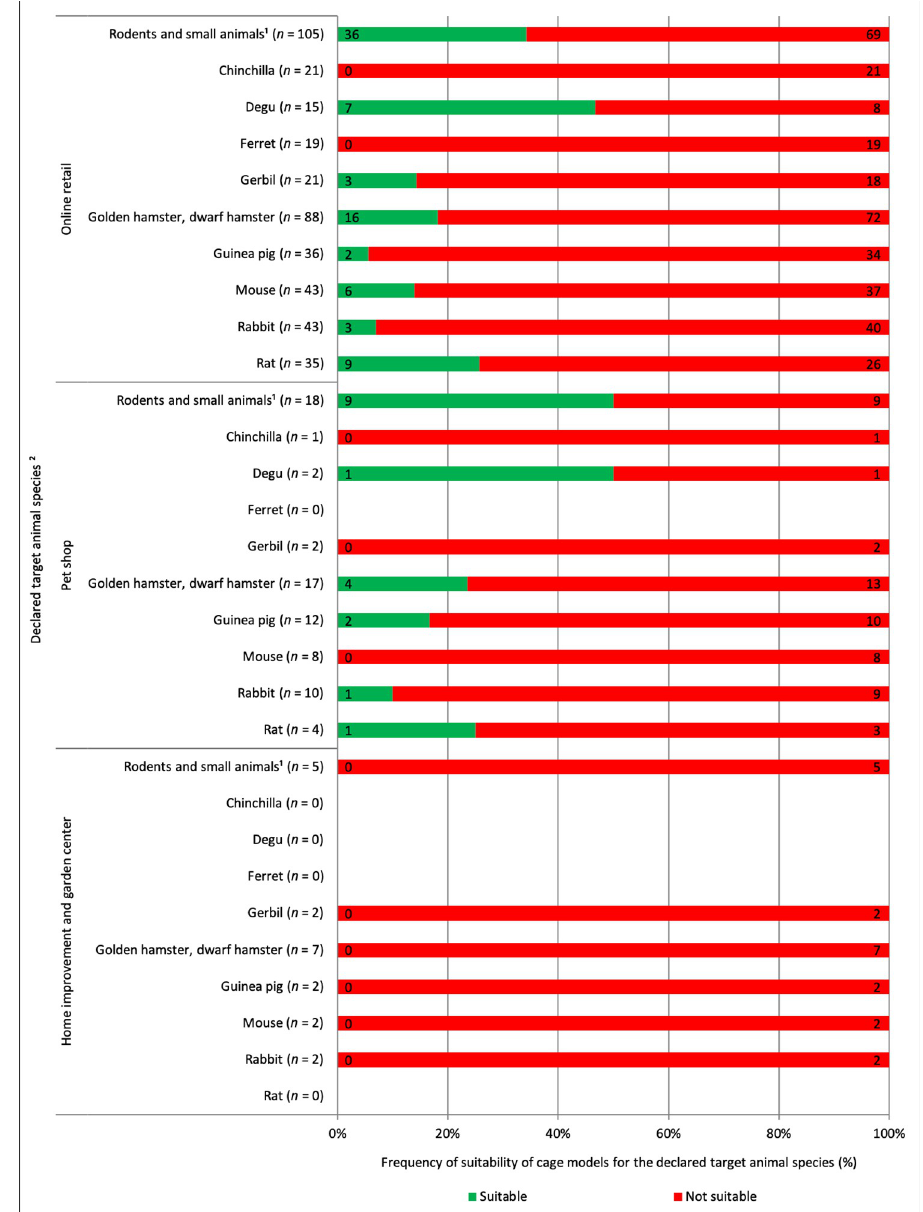
Fig 1. Cage models purchasable in German retail (online via internet shops, on site in pet shops or home improvement and garden centers) and declared for a target animal species, as well as their evaluated suitability for animal-appropriate housing of the declared target animal species, determined based on cage dimensions (floor area and height). Basis for the evaluation: online retail = 208 cage models, pet shops = 36 cage models, home improvement and garden centers = 13 cage models. 1 Relative to housing maximal one golden hamster. 2 Multiple listings